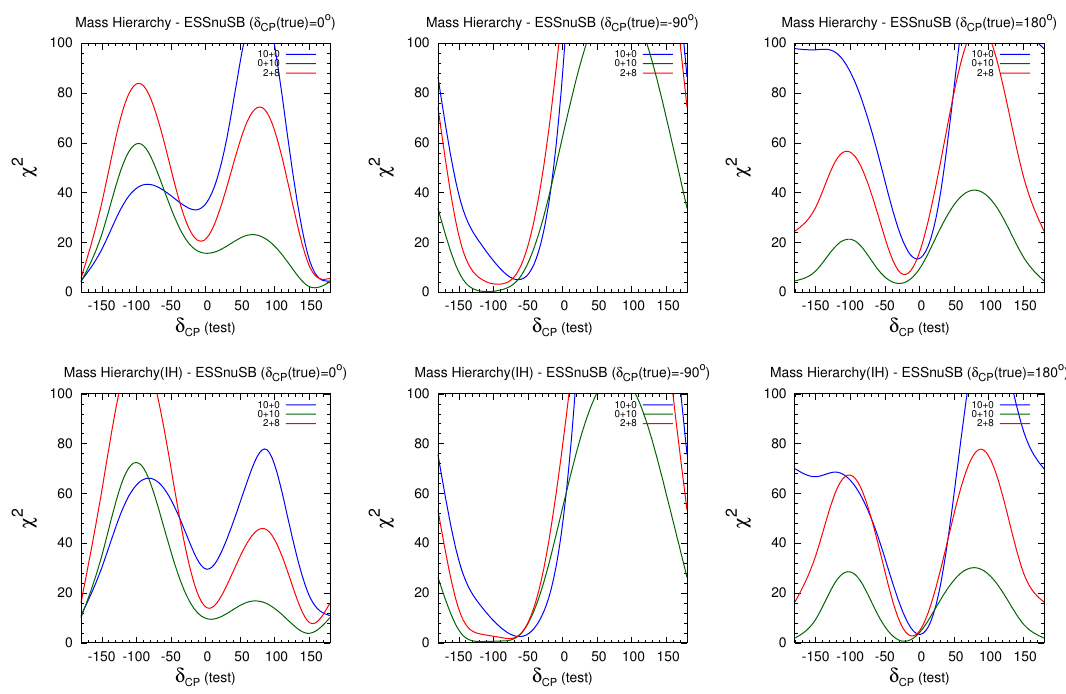
Figure 4 . Mass hierarchy sensitivity vs. (cid:14) CP (test) for ESS (cid:23) SB with true (cid:14) CP (cid:12)xed. The top row represents true NH white the bottom row represents true IH. The true octant is (cid:12)xed as lower octant for all the plots. Each row has plots for three di(cid:11)erent (cid:14) CP (true), which are 0 (cid:14) , (cid:0) 90 (cid:14) and 180 (cid:14) from left to right in the given order. Each (cid:12)gure consists of three di(cid:11)erent runtime combinations of neutrino and anti-neutrino runs. The blue, green and red curves denote the runtime combinations (in years) of 10 (cid:23) + 0(cid:22) (cid:23) , 0 (cid:23) + 10(cid:22) (cid:23) and 2 (cid:23) + 8(cid:22) (cid:23) respectively.